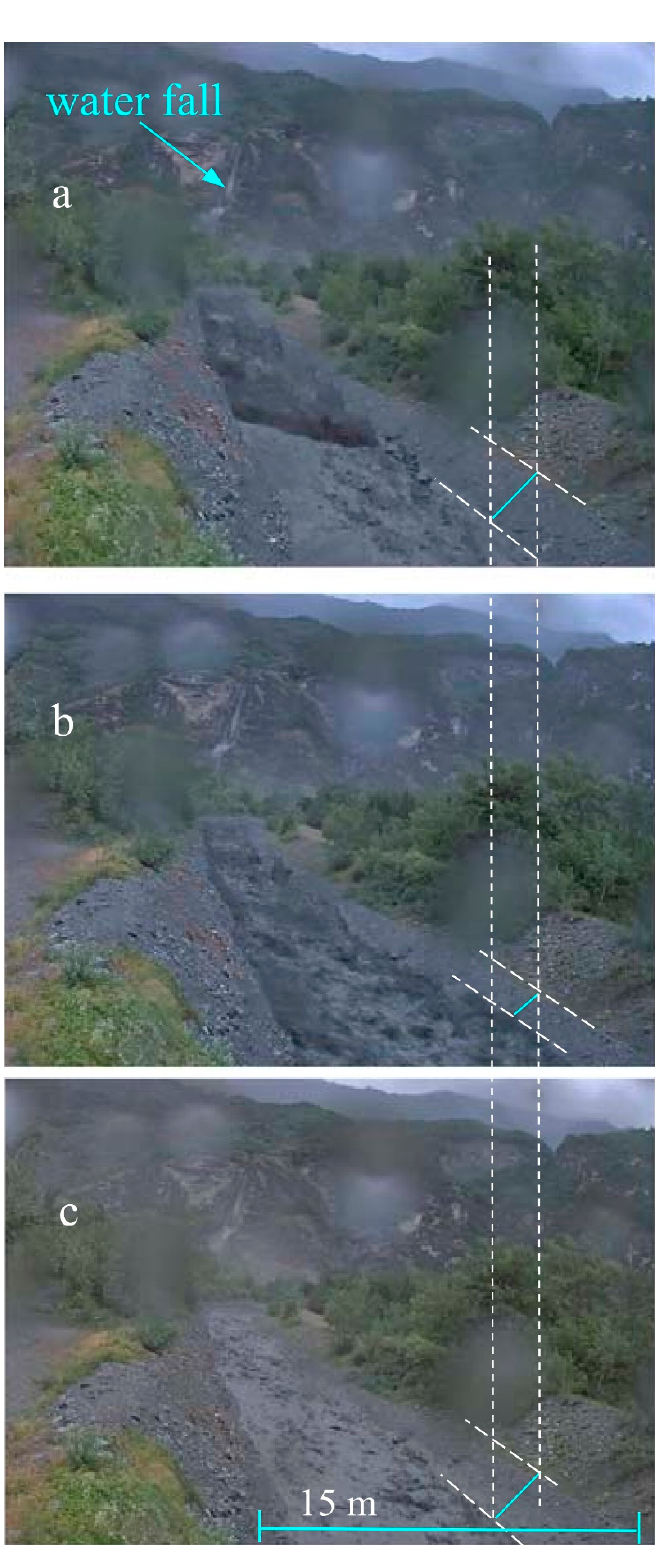
Figure A1. Frames from the movie of the studied event; ( a ) few seconds before the first spike arrival; ( b ) during spikes; ( c ) few seconds after the last spike.